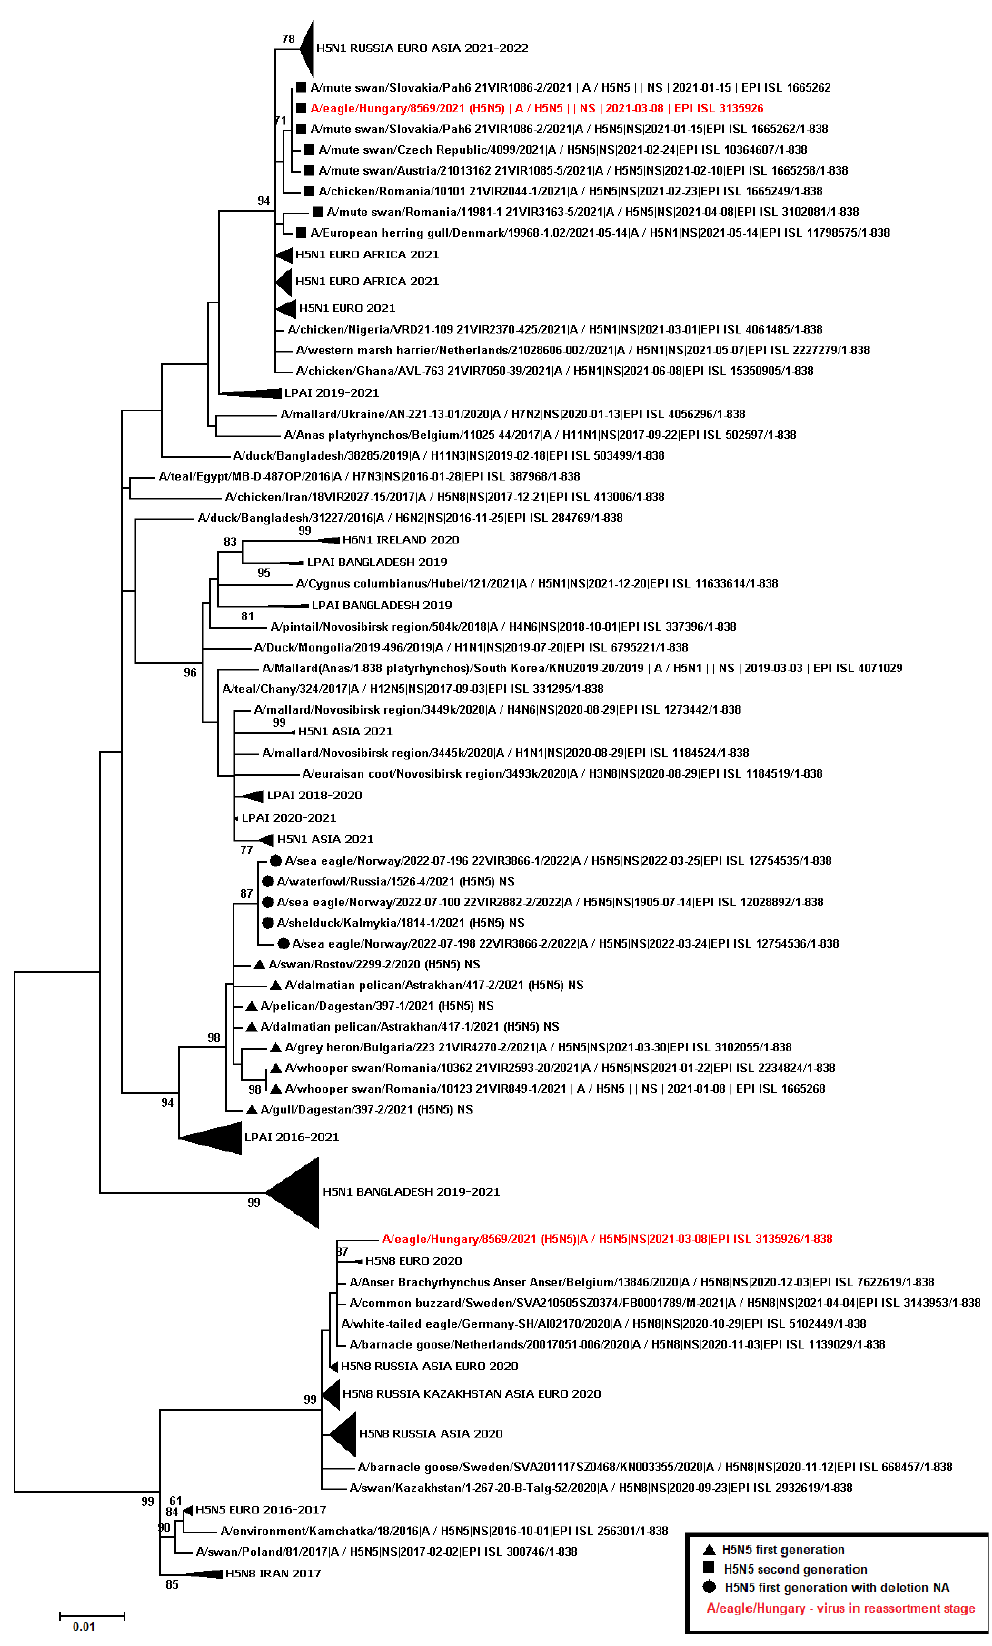
Figure 3. Phylogenetic tree constructed using the NJ method, based on the nucleotide sequence of the NS gene fragment (1–693 bp ORF) of AIV subtype H5.